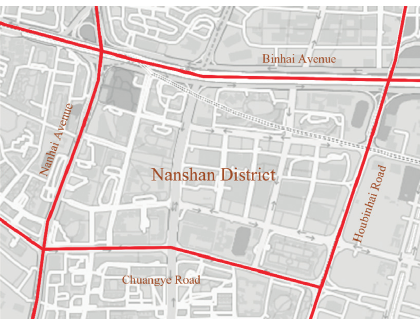
Figure 11: The detailed map of the